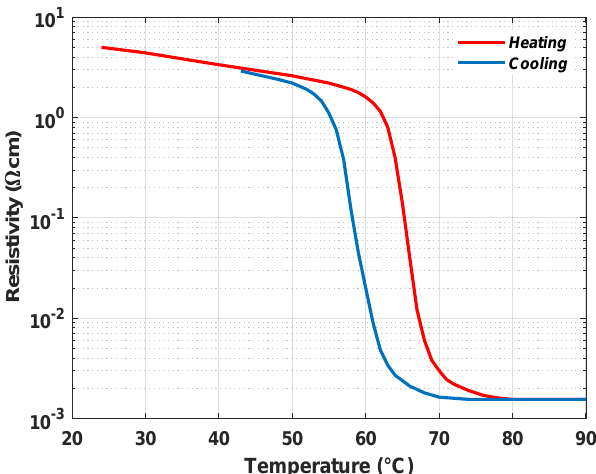
Figure 1. Temperature dependence of the resistivity of vanadium dioxide for (100) VO 2 ; based on [20].